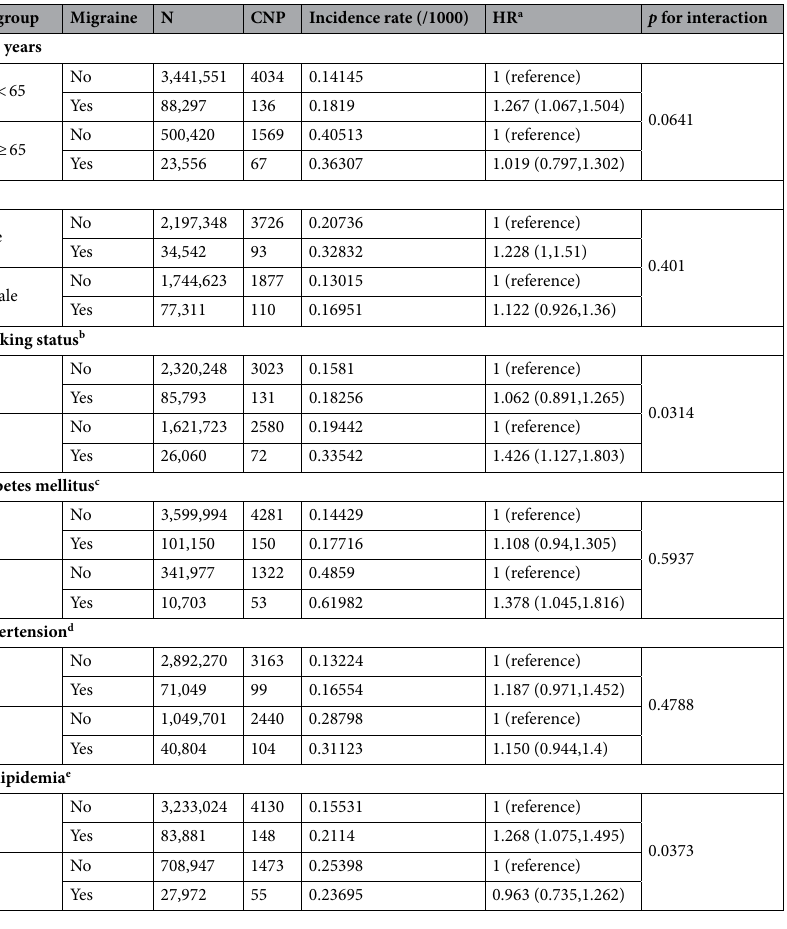
Table 2. Subgroup analysis for the incidence rate of ocular motor CNP. N numbers, CNP ocular motor cranial nerve palsy, IR incidence rate. a The analysis was adjusted for other variables such as age, sex, smoking status, drinking amount, regularity of physical activity, income status, calculated body mass index, and comorbidities including hypertension, diabetes mellitus, dyslipidemia, and glomerular filtration rate. b Smoking status: Smoking status was classified as a non-smoker, ex-smoker, or current smoker. c Diabetes mellitus (DM): DM was defined as fasting glucose of ≥ 126 mg/dL or at least one prescription per year for one or more antidiabetic drugs. d Hypertension (HTN): Hypertension was defined as a prescription at least once per year for antihypertensive drugs under ICD-10-CM codes I10–I13, I15, or a BP of ≥ 140/90 mmHg. e Dyslipidemia: Dyslipidemia was defined as a total cholesterol level of 240 mg/dL or higher or at least one prescription per year for a lipid-lowering drug under ICD-10-CM code